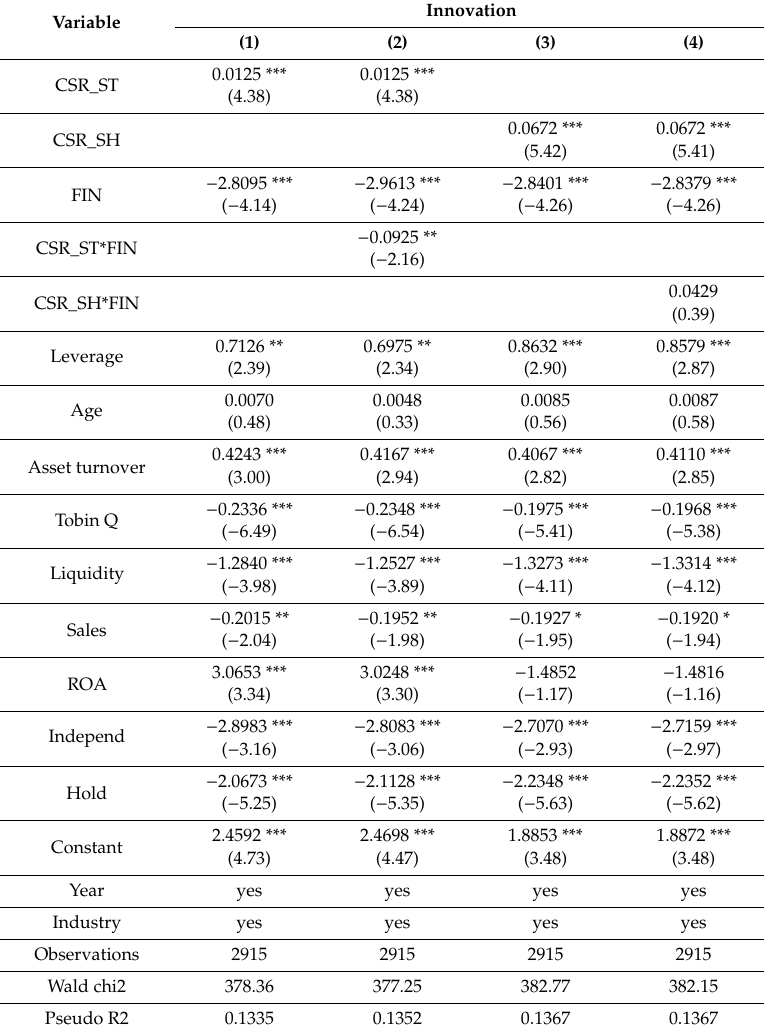
Table 13. Robustness tests of di ff erent CSR